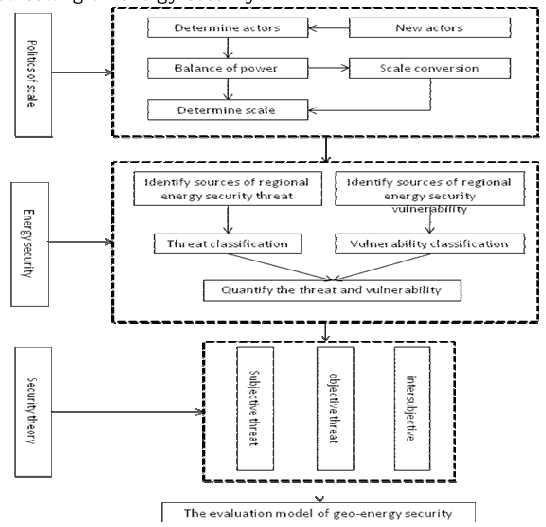
Fig.1 The evaluation of ideas of Geopolitical energy